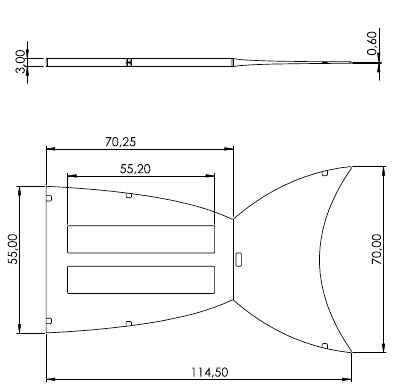
Figure 2. Dimensions of the fish fin structure as the core part of the robot’s body in mm. Rectangle parts represent void spaces down to the neutral plane, holding the textile material.